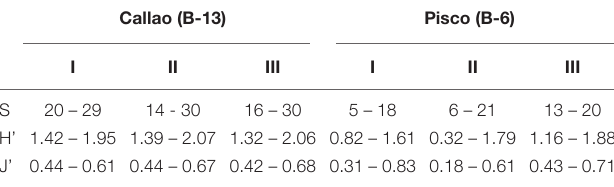
TABLE 1 | Diversity indices of benthic foraminifera for box cores B-13 and B-6. Callao